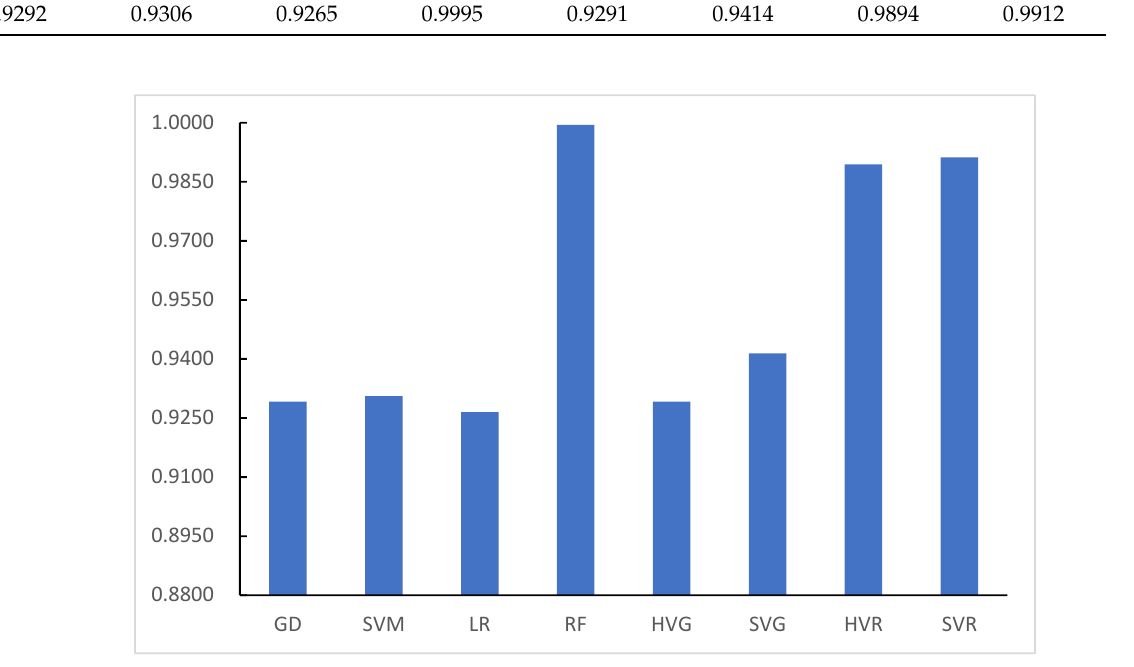
Figure 12. AUC score for model selection algorithms GD, SVM, LR, RF, HVG, SVG, HVR, and SVR. Model selection algorithm AUC scores for each model.